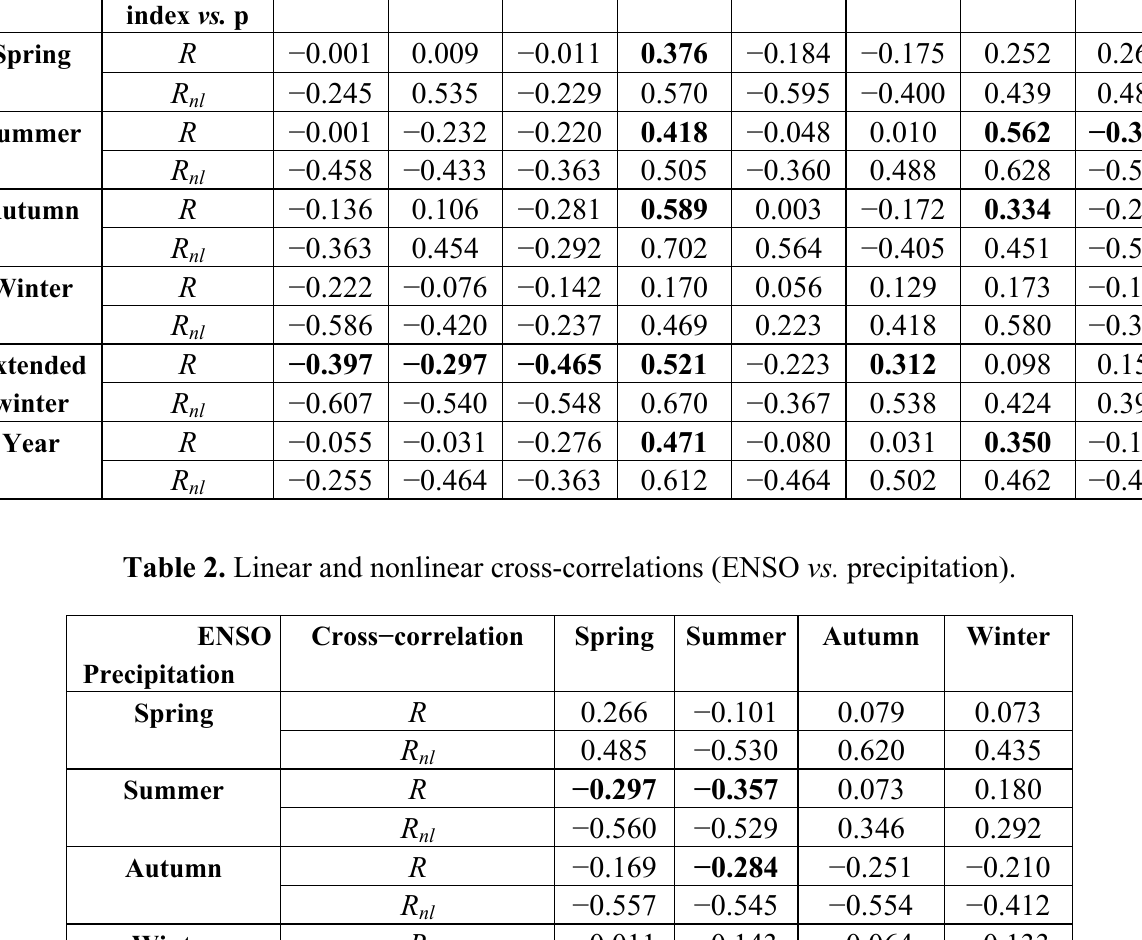
Table 1. Calculation of R and R